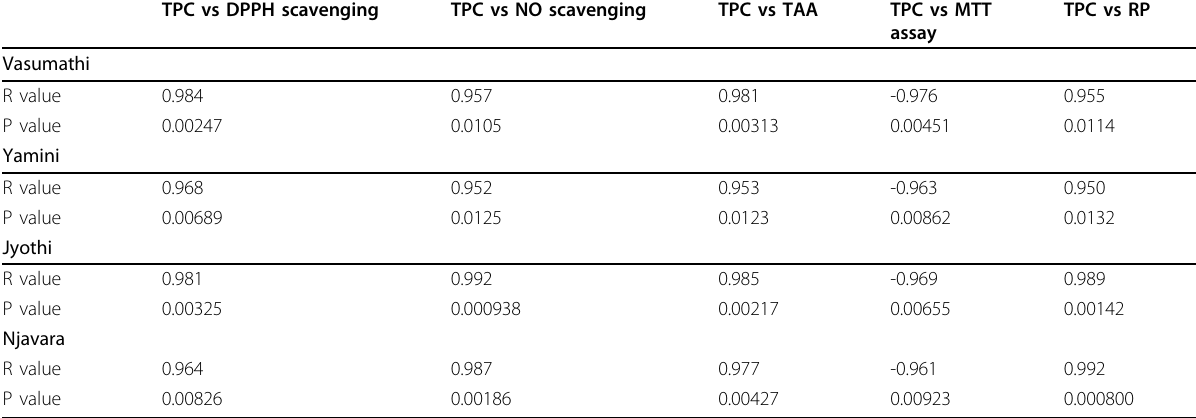
Table 2 Correlation of phenolic contents from the methanolic bran extracts of different rice varieties with DPPH radical scavenging, Nitric oxide (NO) scavenging, Total Antioxidant Assay (TAA), MTT assay and Reducing Power (RP).